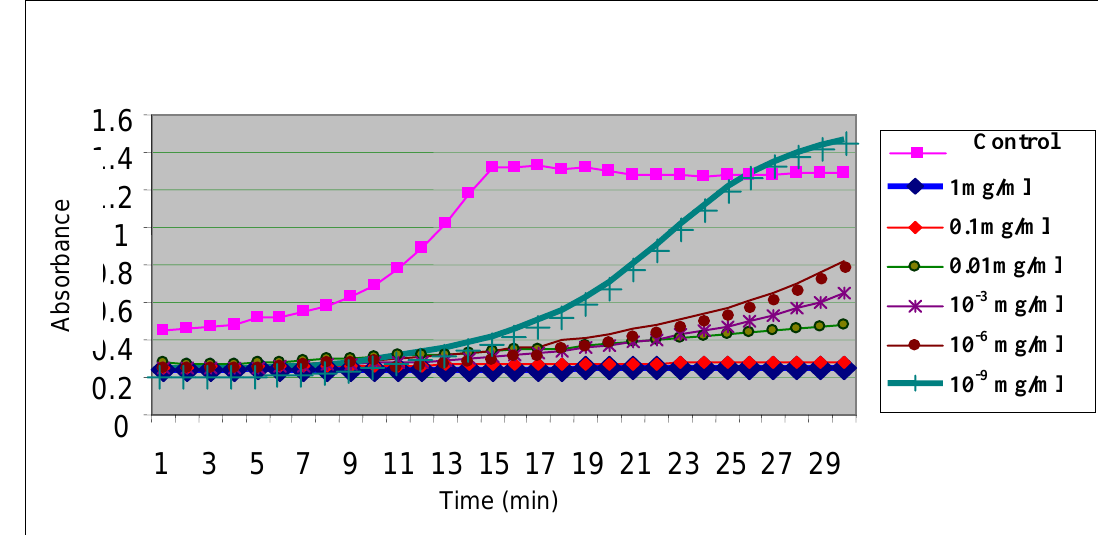
Figure 1. Effect of different melatonin concentrations on the time-course of nitrite–induced oxidation of